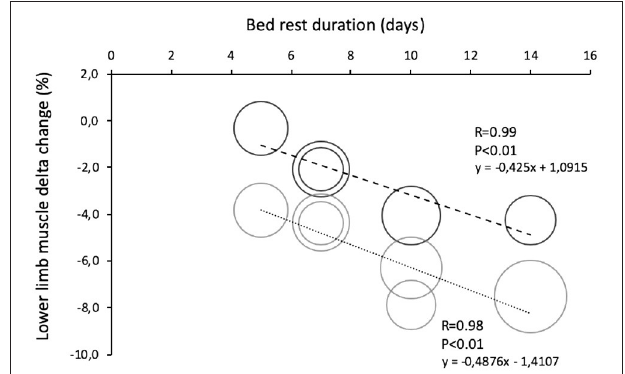
FIGURE 5 | Comparison of lower limb muscle change in young and old during bed rests of different duration. Data are reported as percent differences from a baseline. Solid black round = muscle leg loss in healthy young volunteers (total n = 46 grouped by duration of bed rest). Solid gray round = muscle leg loss in healthy elderly volunteers (total n = 59 grouped by duration of bed